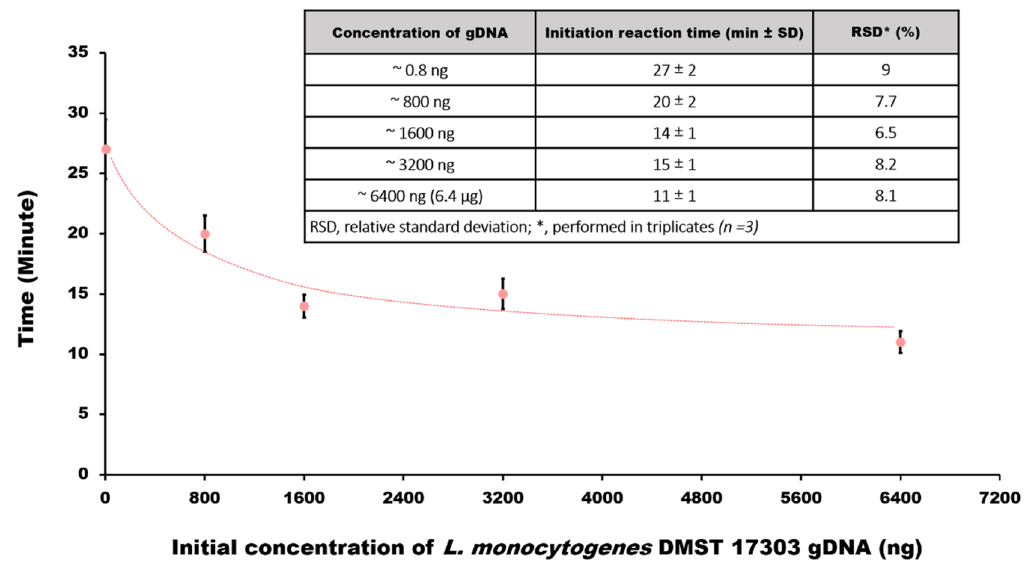
Figure 4. Time for onset of QCM frequency response as a function of initial concentration of target DNA.